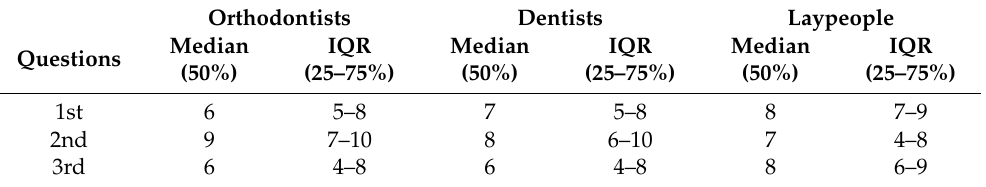
Table 3. Median scores and interquartile value of each group of evaluators for the three questions.